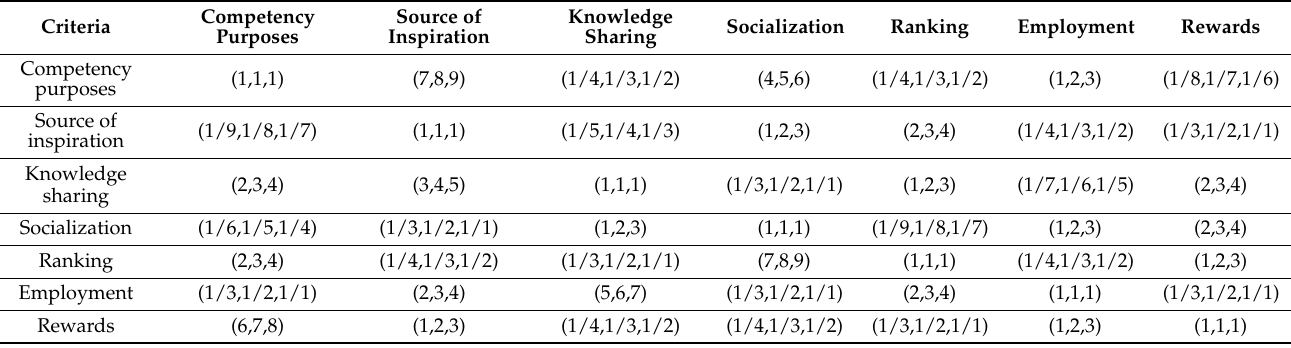
Table 3. Fuzzified decision